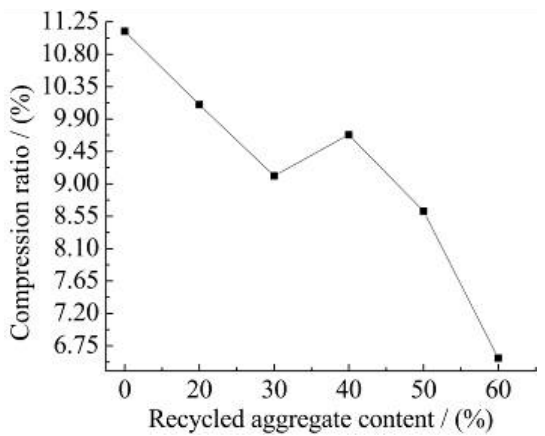
Figure 5. Bend and the compression ratio.